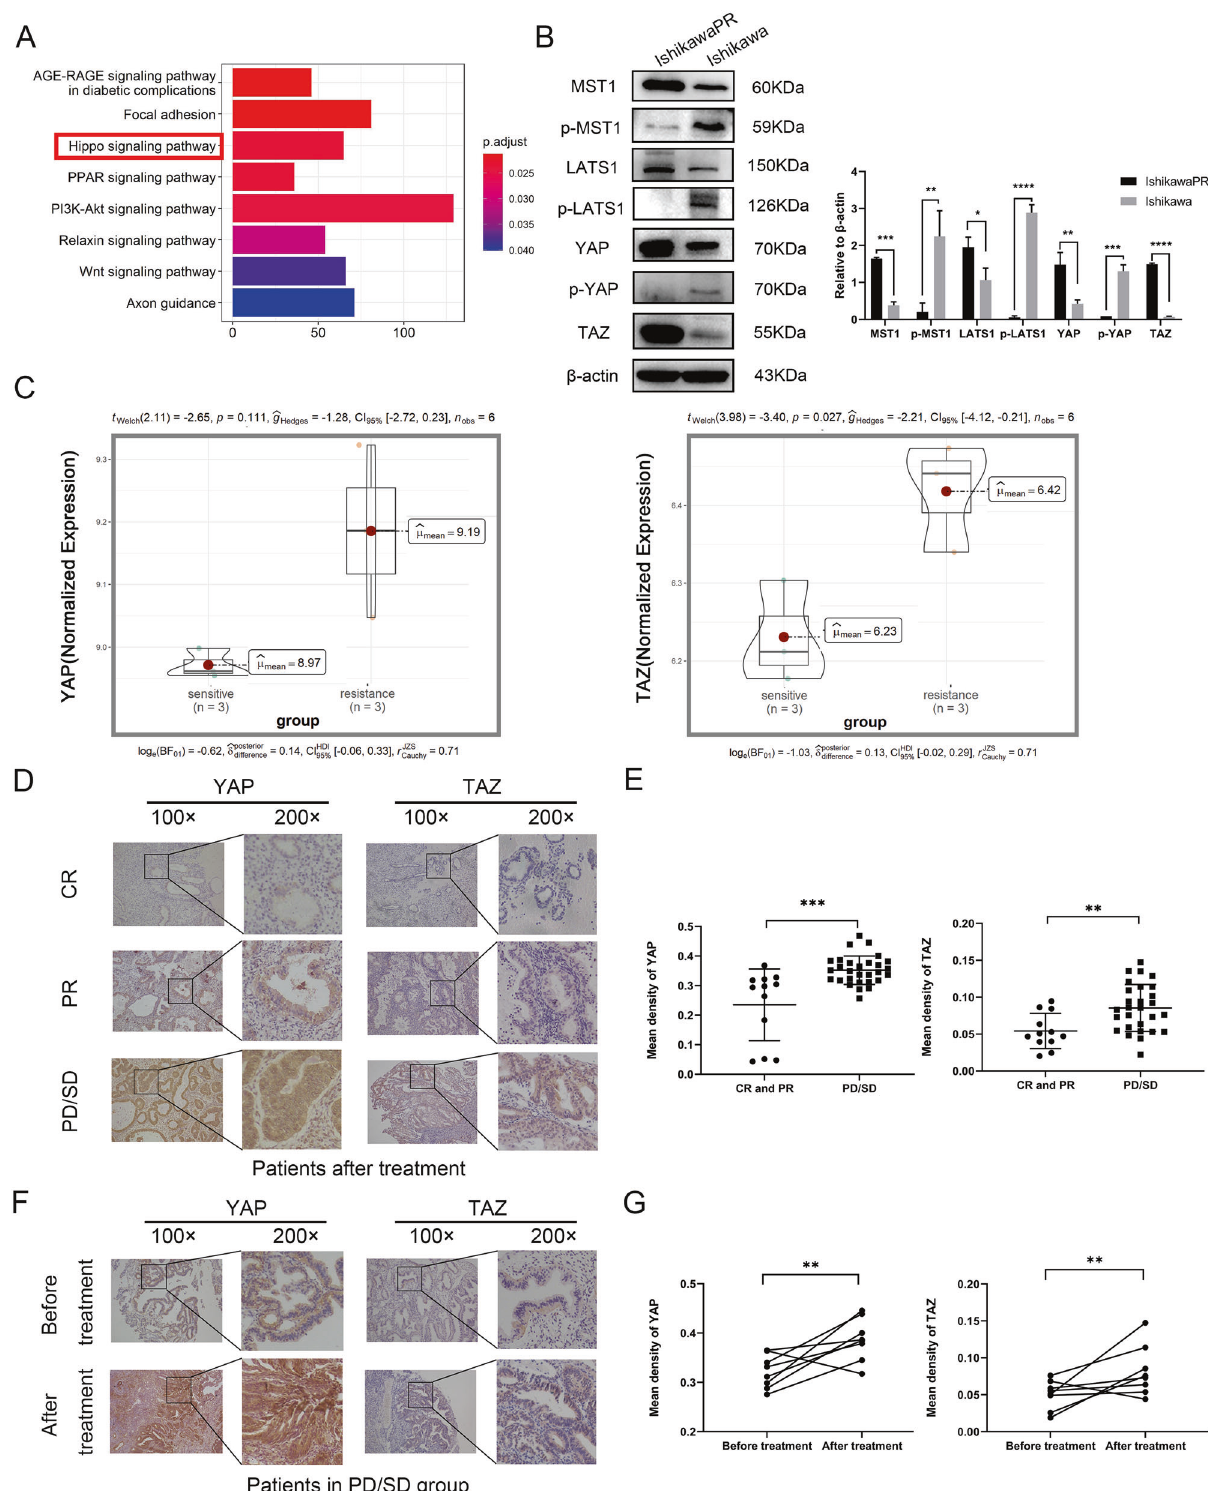
Vertepor fi n is a small molecular photosensitizer which is used to treat neovascular macular degeneration [29]. It has been reported to inhibit proliferation of endometrioid adenocarcinoma cell lines by suppressing YAP/TAZ levels [28]. There are few studies showed that Vertepor fi n could be used clinically to reverse progestin resistance by targeting YAP/TAZ in